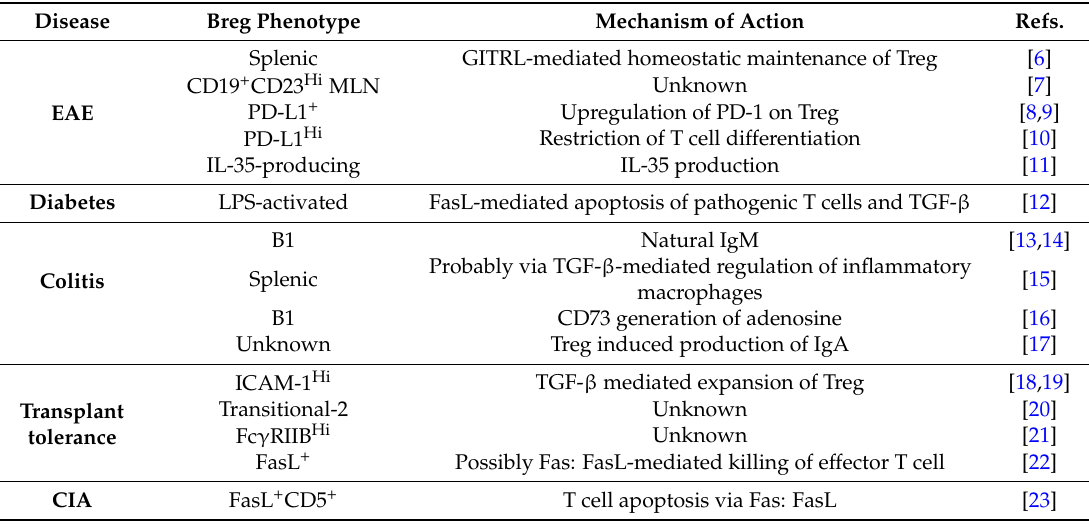
Table 1. Regulatory B cell mechanisms independent of